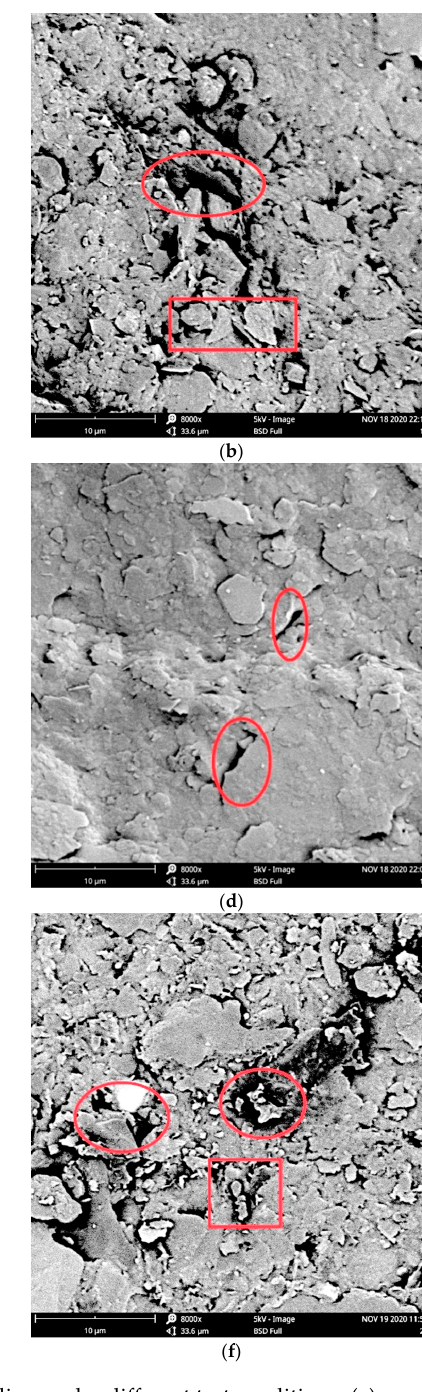
Figure 7. Microscopic scan images before and after loading under different test conditions: ( a ) p 0 = 0, before loading; ( b ) p 0 = 100 kPa, after loading; ( c ) ζ = 0, before loading; ( d ) ζ = 15, after loading; ( e ) OCR = 0, before loading; ( f ) OCR = 9, after loading. Note: circles indicate pores, and squares indicate flocculent structures.